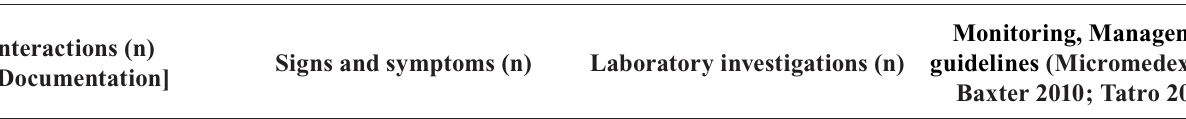
TABLE VI - Top ten interactions, their documentation, clinical relevance and monitoring/management guidelines